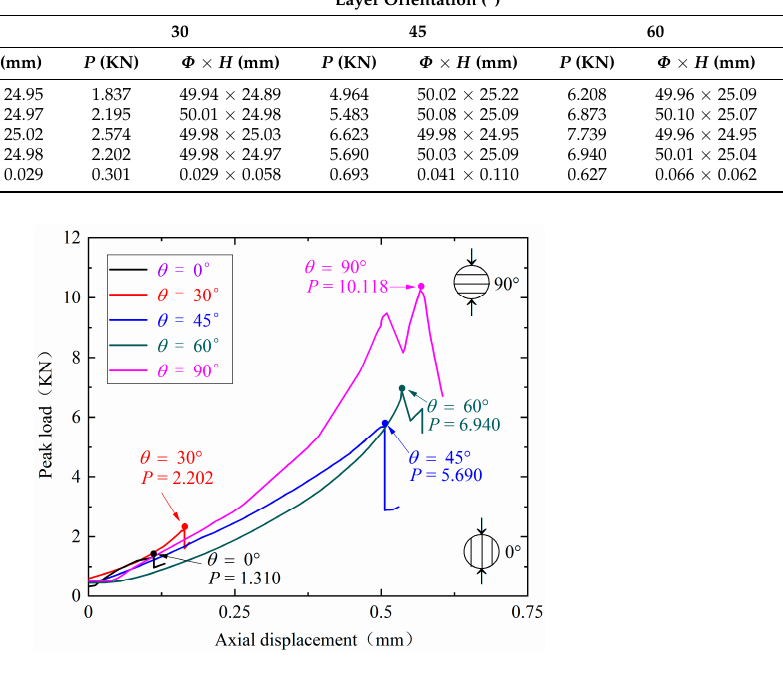
Figure 4. Peak load-displacement curves of continental shale with different layer orientations. Table 1. Statistical table of Brazilian test data of continental shale.